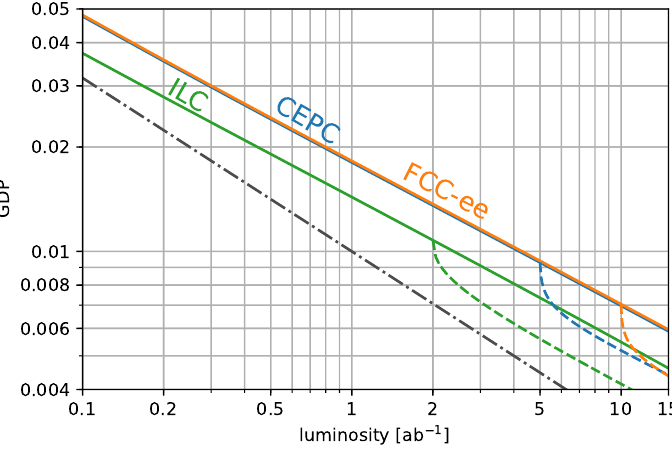
Figure 11 . Global GDP strength of the constraints in our eleven-dimensional parameter space as a function the luminosity collected, without beam polarization, at a center-of-mass energy of 240 GeV (for the CEPC and FCC-ee) and at 250 GeV, with polarized beams (for the ILC). The dashed lines show the improvements brought by subsequent runs at 350 GeV. A pure statistical scaling of constraints, in the absence of systematic uncertainties, would have led to the slope of the dot-dashed